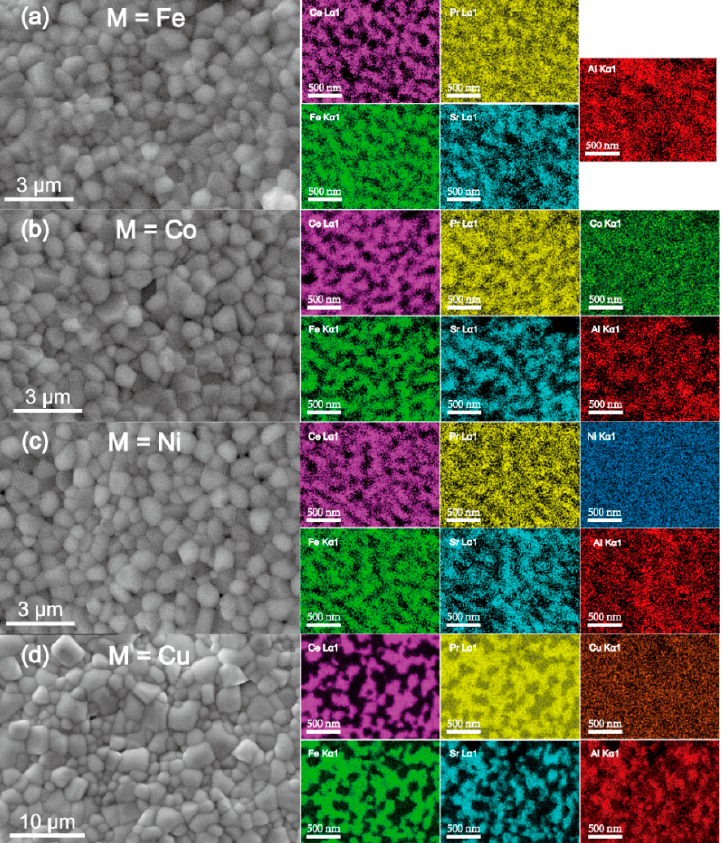
Figure 3. EDXS and element mapping images for ( a ) CPFe-PSFA, ( b ) CPCo-PSFA, ( c ) CPNi-PSFA, and ( d ) CPCu-PSFA composite membranes after sintering at 1275 °C for 5 h.